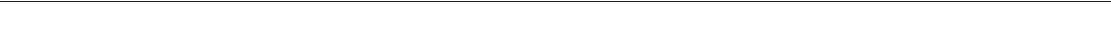
Fig. 1 Systematic mapping of BCL-2 gene dependencies. a Work fl ow. Cell lines from 10 cancer types were treated with all combinations of the BCL-X L inhibitor WEHI-539 (1 µ M), the BCL-2 inhibitor ABT-199 (1 µ M), and/or the MCL-1 inhibitor A-1210477 (10 µ M) for 3 days in a 96 well plate and assessed for changes in viability via Cell Titer-Glo (CTG). b A heatmap showing BCL-2 gene dependencies from six control cell lines that have known dependencies on: BCL-2 (MOLM13), BCL-X L (Panc 03.27), MCL-1 (H23), BCL-2 + BCL-X L (THP1), BCL-2 + MCL-1 (AML3), and BCL-X L + MCL-1 (HCC1143). Percentage viability loss is calculated as 100 – (the % viability signal determined from the CTG assay) and is colored from 0 % viability loss (blue) to 100 % viability loss (red). c Heatmap of BCL-2 gene dependencies in cell lines representing: acute myeloid leukemia (LAML), high-grade serous ovarian carcinoma (OV), colorectal adenocarcinoma (COAD), pancreatic ductal adenocarcinoma (PAAD), non-small cell lung carcinoma (LUAD), melanoma (SKCM), liver (LIHC), bladder (BLCA), breast (BRCA), glioblastoma (GBM). d Patient-derived cell lines from COAD or PAAD tumors were assayed for BCL-2 gene dependencies. e An in vivo xenograft model of JH4.3 cells grown in athymic mice. Once tumors reached 100 mm 3 , mice (6-7 per group) were treated with vehicle or the BCL-X L inhibitor A-1331853 (25 mg/kg, qd) until the vehicle group reached 1000 mm 3 (35 days). A 2-way ANOVA between vehicle ( n = 5) and treated ( n = 7) groups yielded a signi fi cant p -value (*, p =